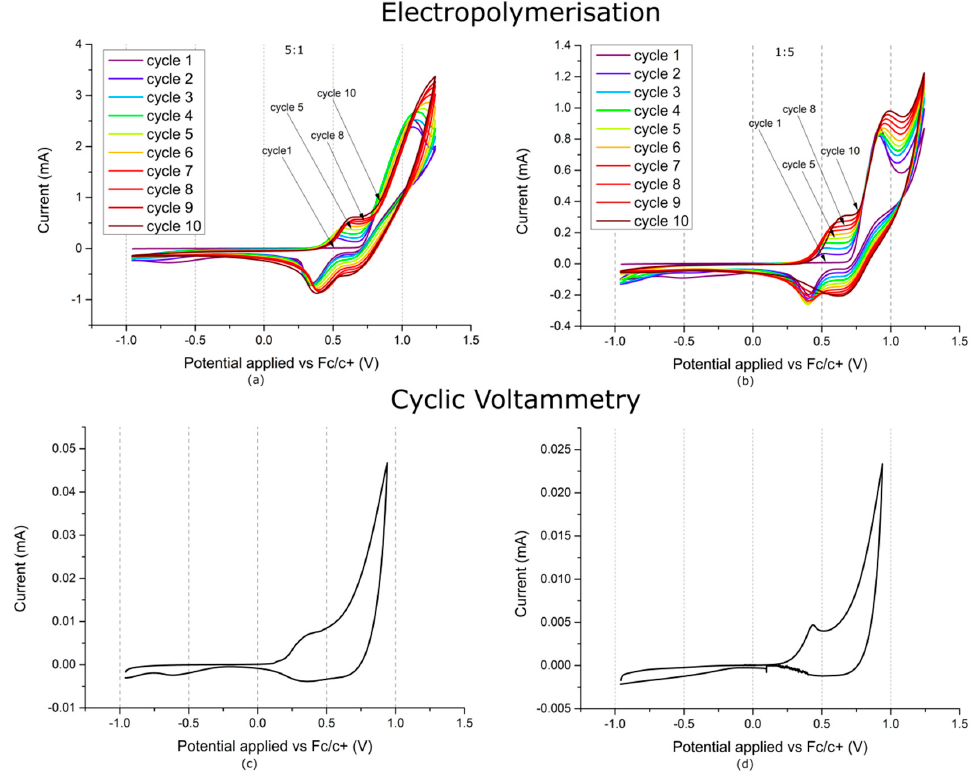
Figure 4. Electrochemical polymerisation of Cz-HT 5:1 ( a ), Cz-HT 1:5 ( b ), CVs of deposited Cz-HT 5:1 EP ( c ), Cz-HT 1:5 EP ( d ) layers. EP ( c ), Cz-HT 1:5 EP ( d )